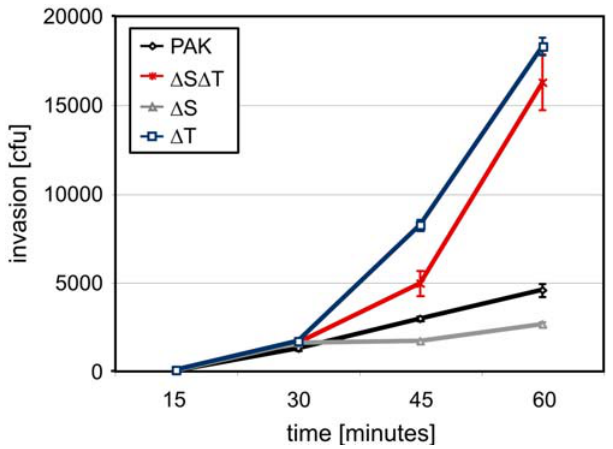
Figure 5. Kinetics of internalization of PAK into mammalian cells. Invasion of PAK, PAK D S D T, PAK D S and PAK D T in HeLa cells at the indicated times was quantified. Shown are the mean + / 2 SD from three independent